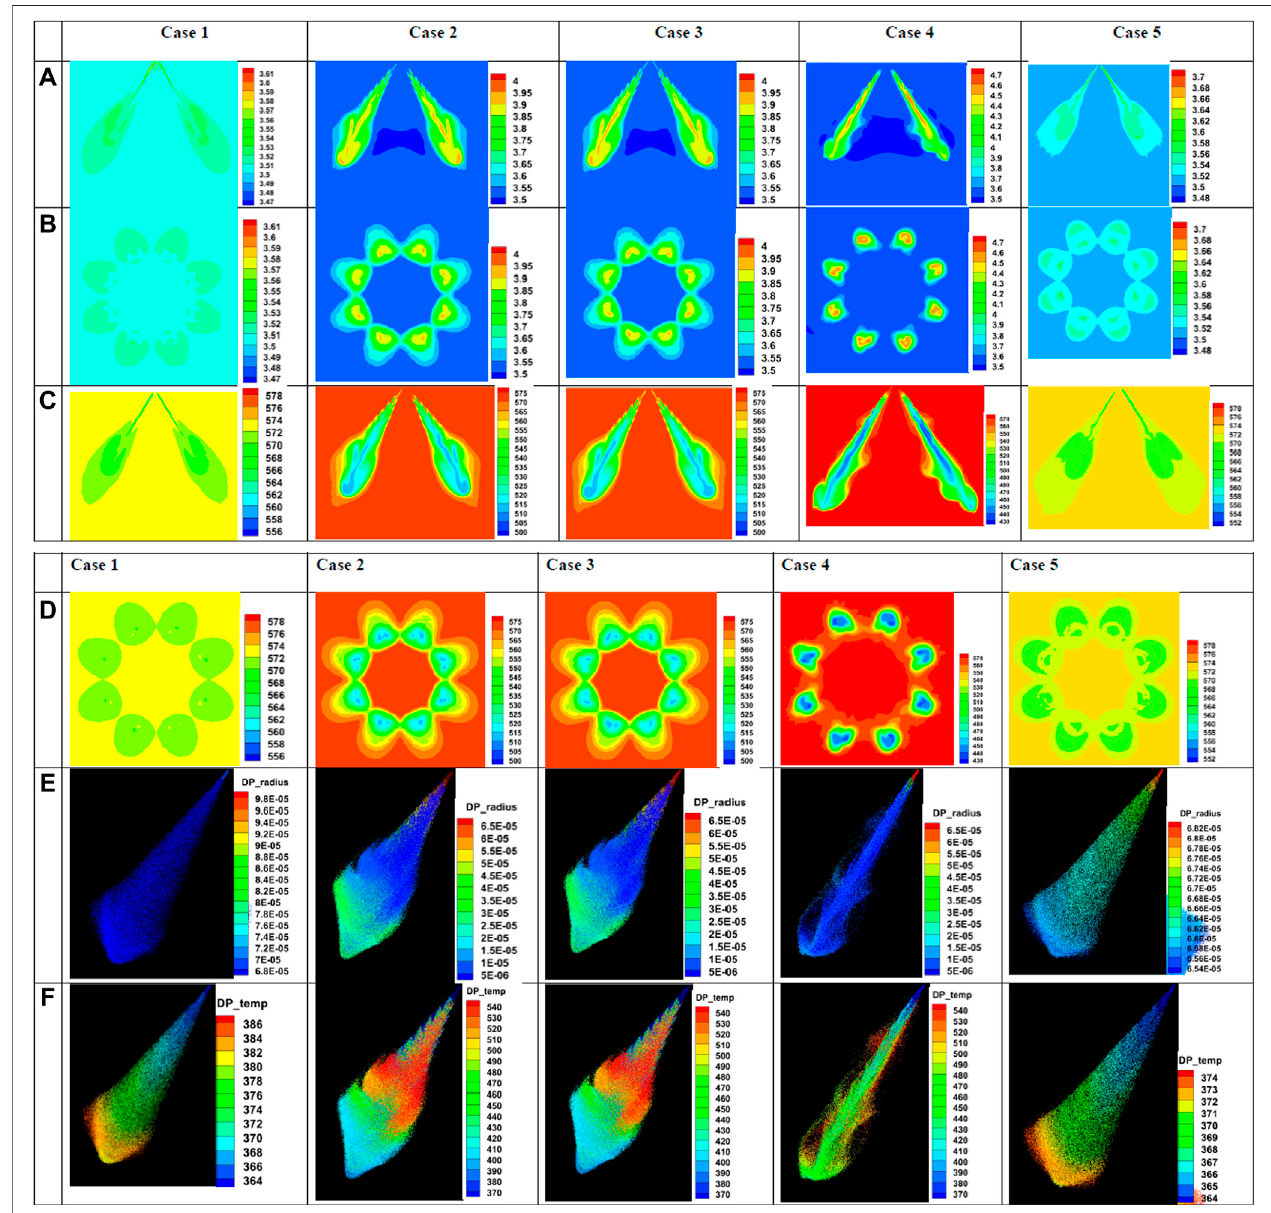
FIGURE 13 | Effects of deactivating the spray submodels on different variables.